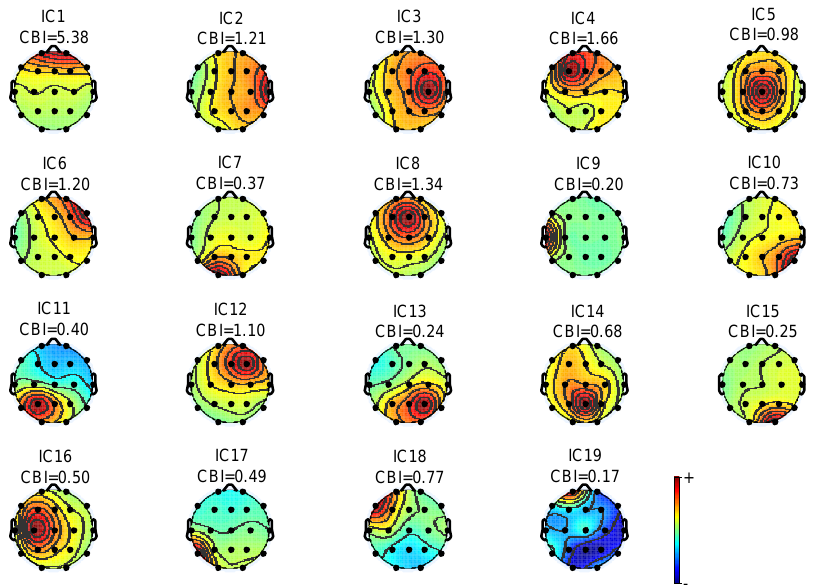
Figure 5. The power topographic of independent components for first